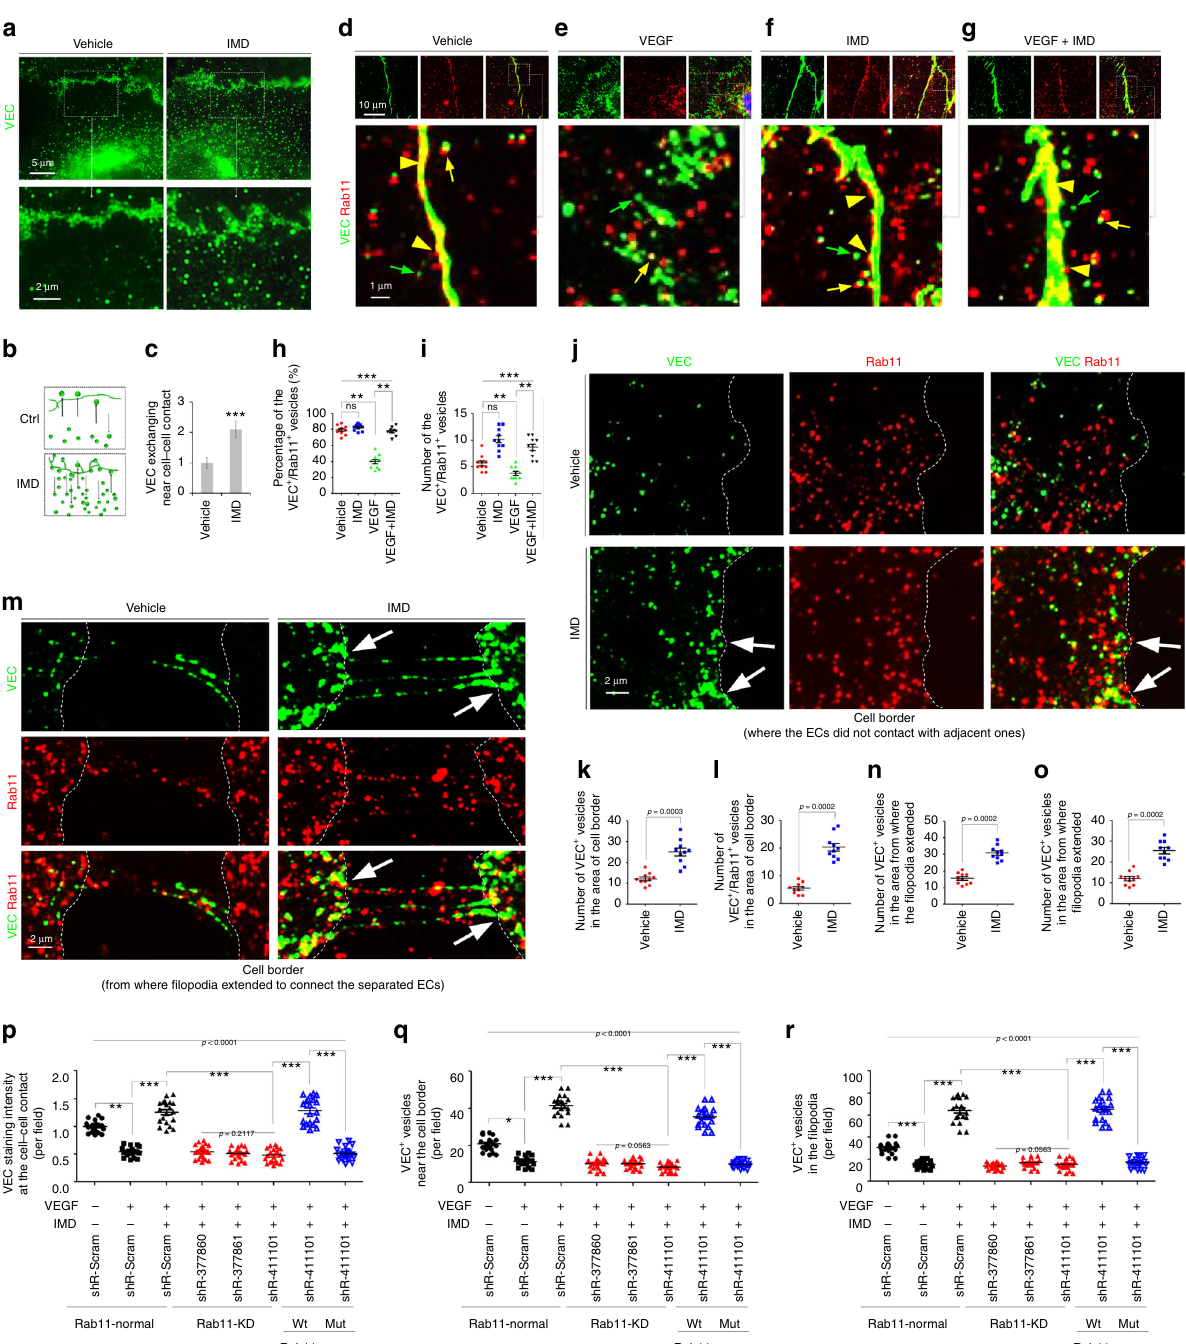
Fig. 2 Rab11 facilitates the IMD-induced VEC re-localization. a The HUVECs treated with vehicle (PBS) or IMD 40 (2 μ M) were stained with VEC (green). b The schematic of the VEC endosome exchange at the cell – cell contact. c The VEC exchange was quanti fi ed using 10 randomly chosen fi elds from two experiments and expressed relative to the vehicle group. d – g The Antibody feeding assay was performed as described in Methods. The HUVEC monolayer was treated with PBS, IMD, VEGF, or VEGF plus IMD. The internalized VEC endosomes were detected by pre-incubation of anti-VEC (green), and double- stained with anti-Rab11 (red). The yellow arrows indicate the VEC + /Rab11 + double-positive vesicles, the yellow arrowheads indicate the Rab11 + vesicles fused to the VEC-complexes, and the green arrows indicate the VEC + endosomes that did not co-localized with Rab11. h, i The percentage of VEC + /Rab11 + vesicles in total VEC + vesicles and the absolute number of them were quanti fi ed using 10 randomly chosen fi elds. j, m The Antibody feeding assay showed the VEC + and Rab11 + vesicles at the cell border of HUVECs. k, l, n, o The number of VEC + or VEC + /Rab11 + double-positive vesicles in the area of cell border where cells did not contact with adjacent ones ( k,l ), or the area from where the fi lopodia extended to connect the separated ECs ( n, o ) were quanti fi ed using 10 randomly chosen fi elds. p, q, r The HUVECs were transfected with the shRNAs of Rab11 (shR-377860, shR-377861, shR-411101), followed by the treatment of VEGF with or without IMD 40 . shR-411101 that targets the 3 ′ -UTR of Rab11 was rescued by transfecting the vector that expresses wild type or mutant Rab11 lacking 3 ′ -UTR. The VEC staining intensity at the cell – cell contact, and the VEC + vesicles at the cell border and in the fi lopodia were quanti fi ed using 10 randomly chosen fi eld. All data were presented as scatter plots with mean ± SEM. Signi fi cance was assessed by Mann – Whitney test ( c, k, l, n, o ) and Kruskal – Wallis test followed by non-parametric Dunn ’ s post-hoc analysis ( p – r